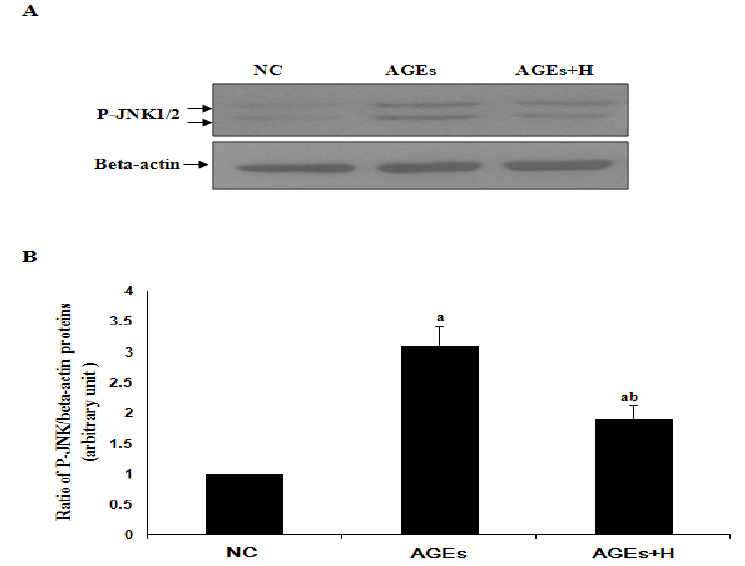
Figure 2. Hyperoside inhibits AGE-induced activation of JNK in ECV304 cells. ( A ) Western blotting shows the activation of c-Jun N -terminal kinases (JNK) (P-JNK) in ECV304 cells in response to AGEs in the absence or presence of hyperoside; ( B ) The statistical results of (A) show ( a ) vs. NC ( p < 0.05); and ( b ) AGEs + H vs. AGEs ( p < 0.05). Results are from three independent experiments; β -actin was used as an internal control. NC, negative control; H,